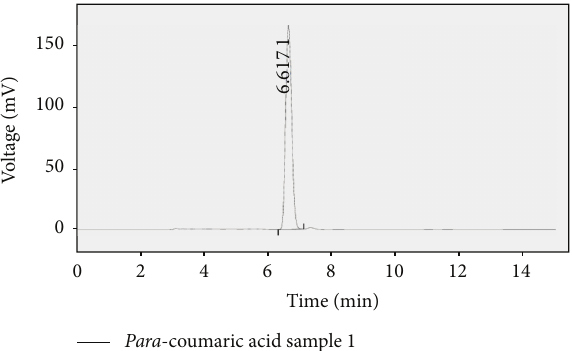
Figure 4: Chromatogram of methanolic extract of P-coumaric acid in durva grass.